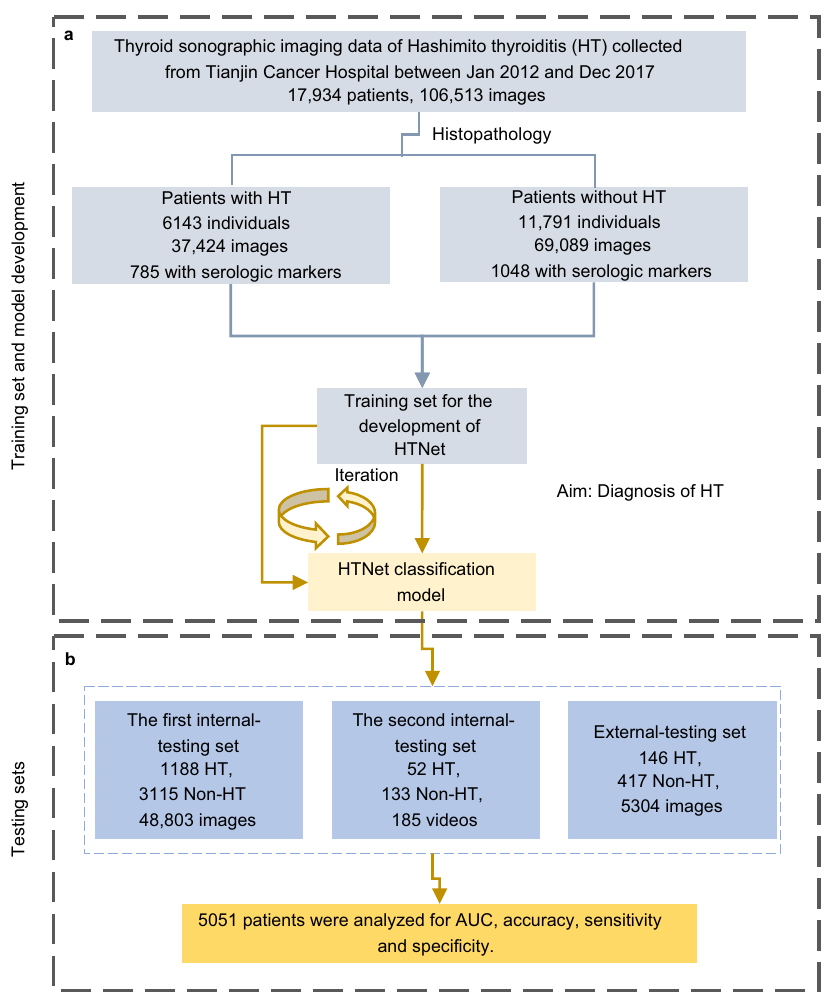
Fig. 1 A fl owchart depicting the development of HTNet. a Data curation and development of HTNet. b Evaluation of HTNet on testing sets. HT Hashimoto thyroiditis. All individuals in the training and testing sets have pathological reports for the determination of the ground truth of HT.